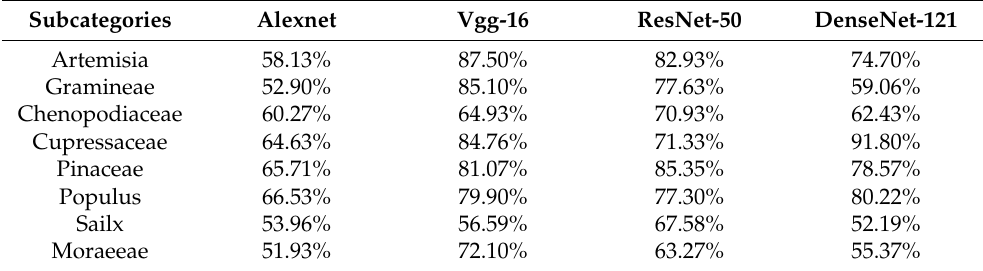
Table 5. The accuracy results of different classifiers on various pollen subcategories.